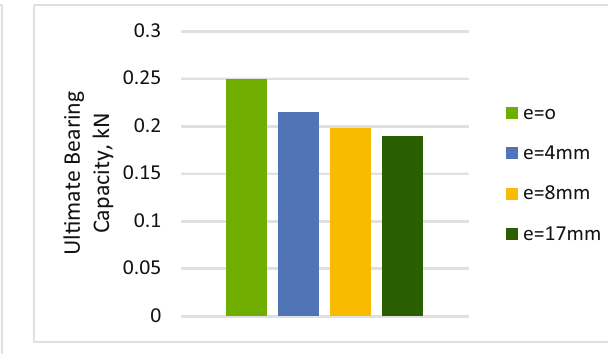
Figure 11: Load – settlement ratio relationship at D s = 1 B .